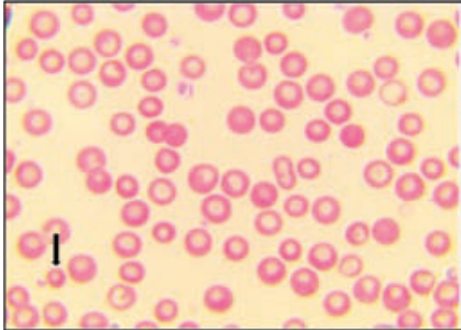
Fig. 5 . Numerous normochromic-microcytes in a peripheral blood smear, 1000 X magnification, Field